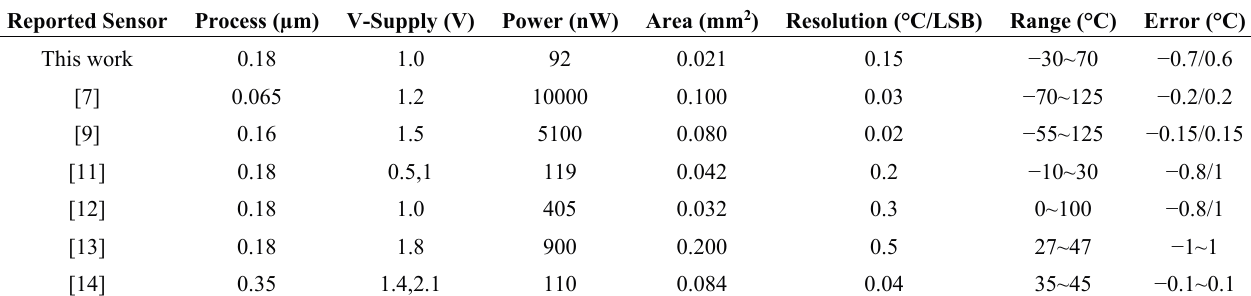
Table 1. Performances comparison of temperature